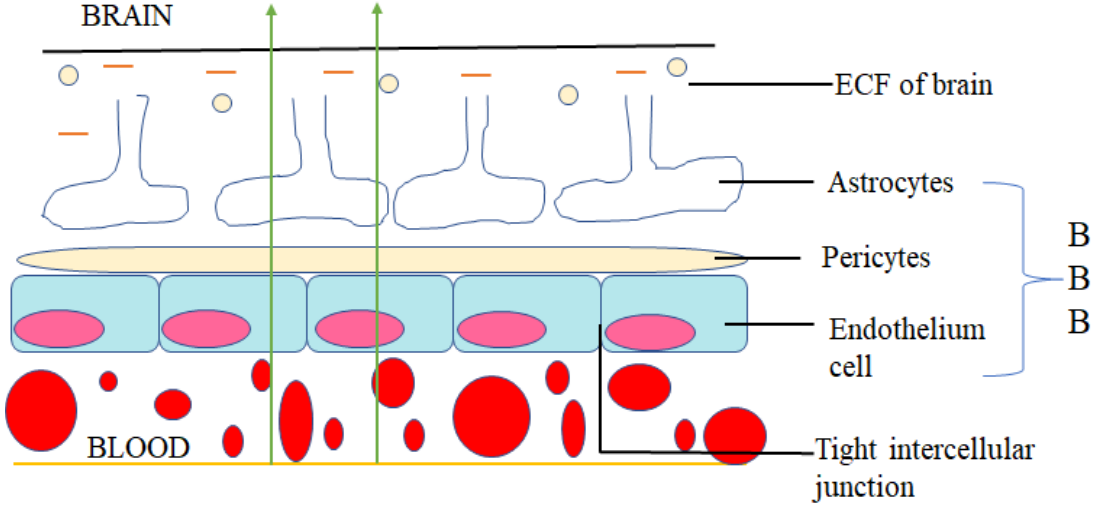
Fig. 1. Blood brain barrier